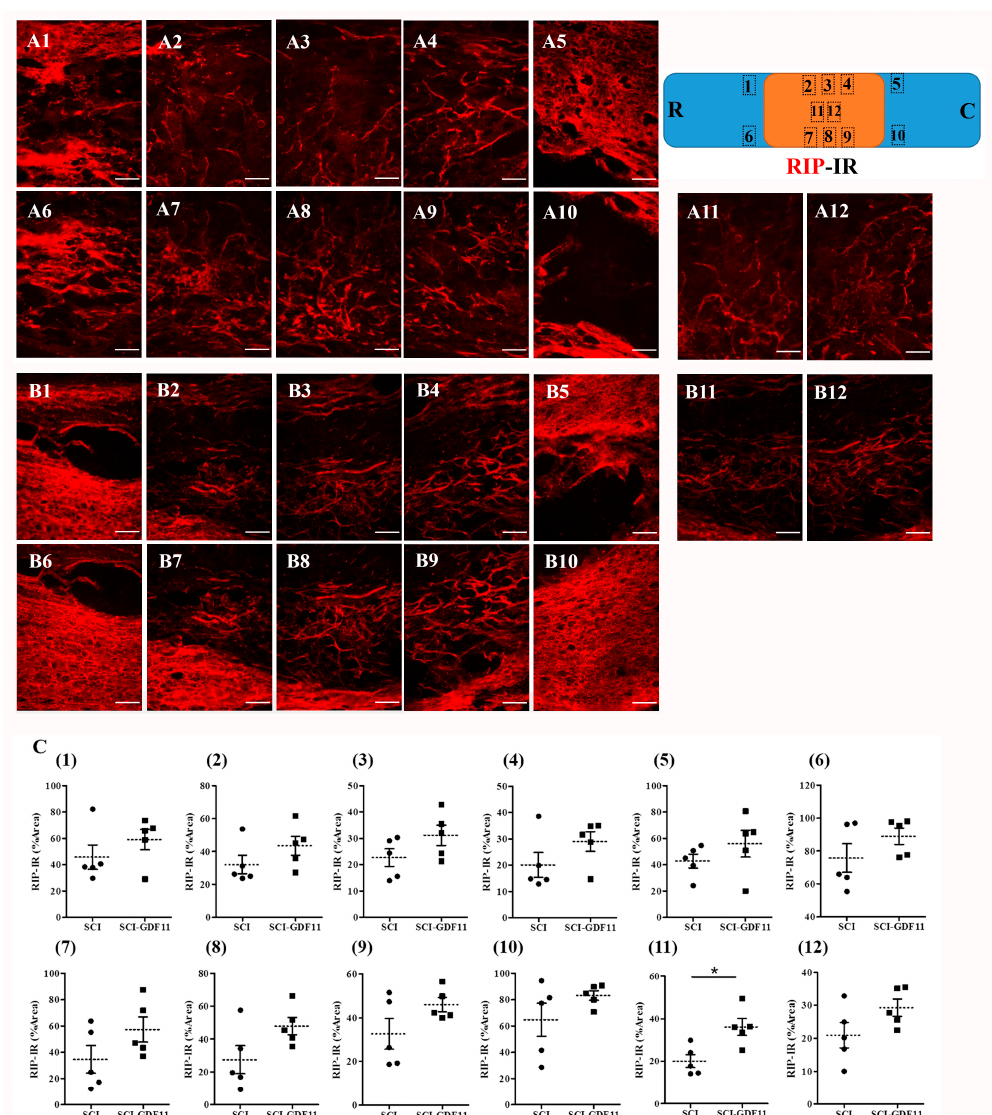
Figure 9. RIP-immunoreactive oligodendroglia in the thoracic spinal cords of SCI rats 6 weeks after injury. ( A ) Representative images of longitudinal spinal cord sections in an SCI rat. ( B ) Representative images of spinal cord sections in a GDF11-treated SCI rat. ( C ) Quantification of RIP-IR shown in areas (1–12) of ( A ) or ( B ) panel from, respectively, control- or GDF11-treated spinal cord sections. The upper-right scheme shows segments of the thoracic spinal cord (T7~T9; R: rostral; C: caudal). The locations of RIP-IR photo taken in areas (1–12) were depicted. Note the significant increase in RIP-positive oligodendroglia in GDF11-treated groups in area (11) at 6 weeks post-injury. RIP- IR in area (8) has a tendency to increase ( p = 0.077) but did not reach a significant level. GDF11 was administered to SCI rats through tail vein injection after spinal cord contusion. After 6 weeks, immunofluorescence-positive areas of RIP were detected in a longitudinal section at the epicenter of the spinal cord. The results are reported as mean ± SEM from 5 rats per group. Statistical significance is evaluated using unpaired Student t -test. * p < 0.05 SCI versus SCI-GDF11. Magnification: 200 × . Scale bar: 100 µ